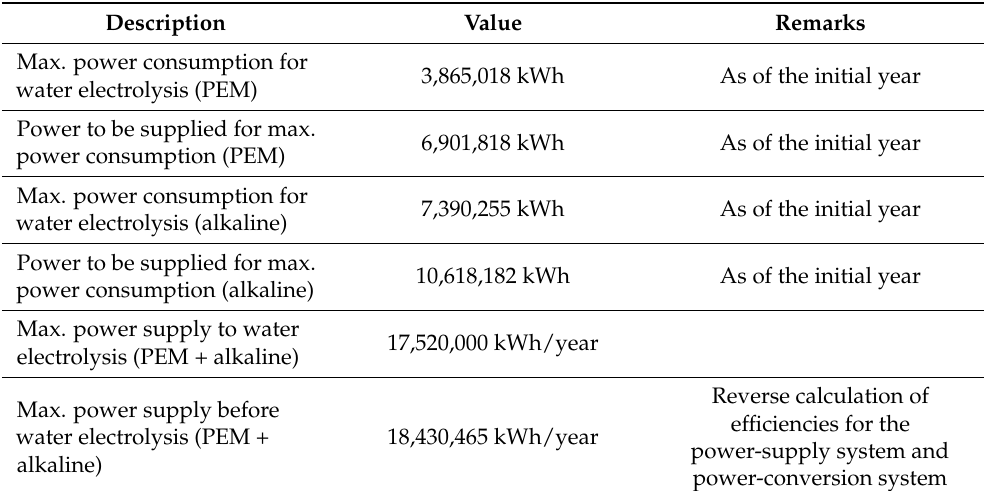
Table 36. Reverse calculation of required supply amount for occupying maximum